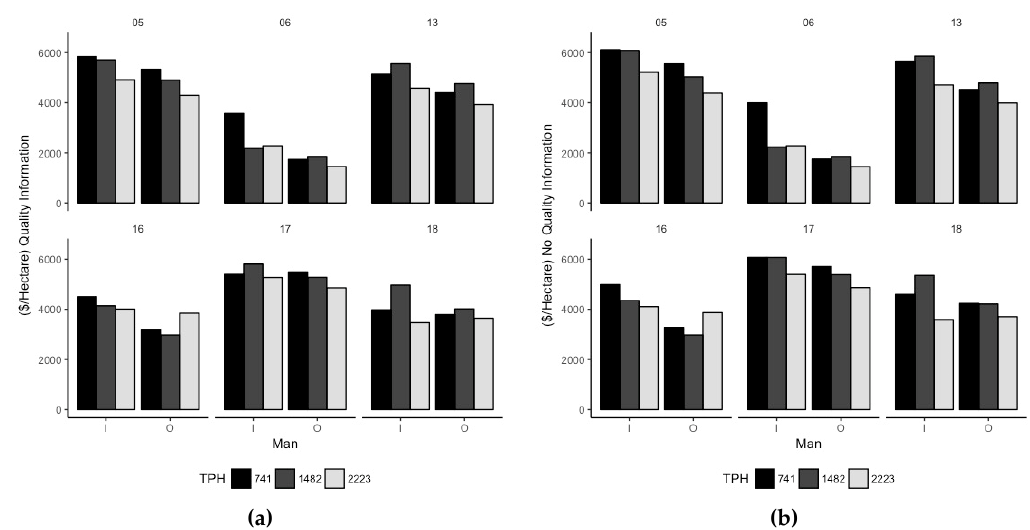
Figure 5. Age 16 standing timber value (U.S. $/hectare) for each installation (installation number indicated above bars), management intensity (Man), and planted trees per hectare (TPH). Man “I” = intensive, “O” = operational. Value displayed with tree quality information considered ( a ) and without quality information ( b ).